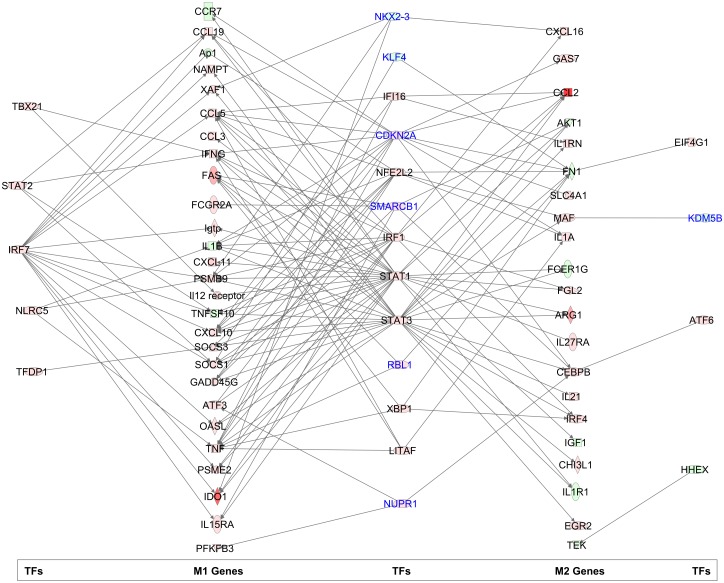
Predicted transcription factor regulation of M1- and M2-associated gene expression in splenic macrophages from hamsters with VL.The set of differentially expressed genes in splenic macrophages was loaded into IPA software to predict the transcription factors likely to be activated. Shown is the overlapping network analysis of these transcription factors and the differentially expressed transcripts.